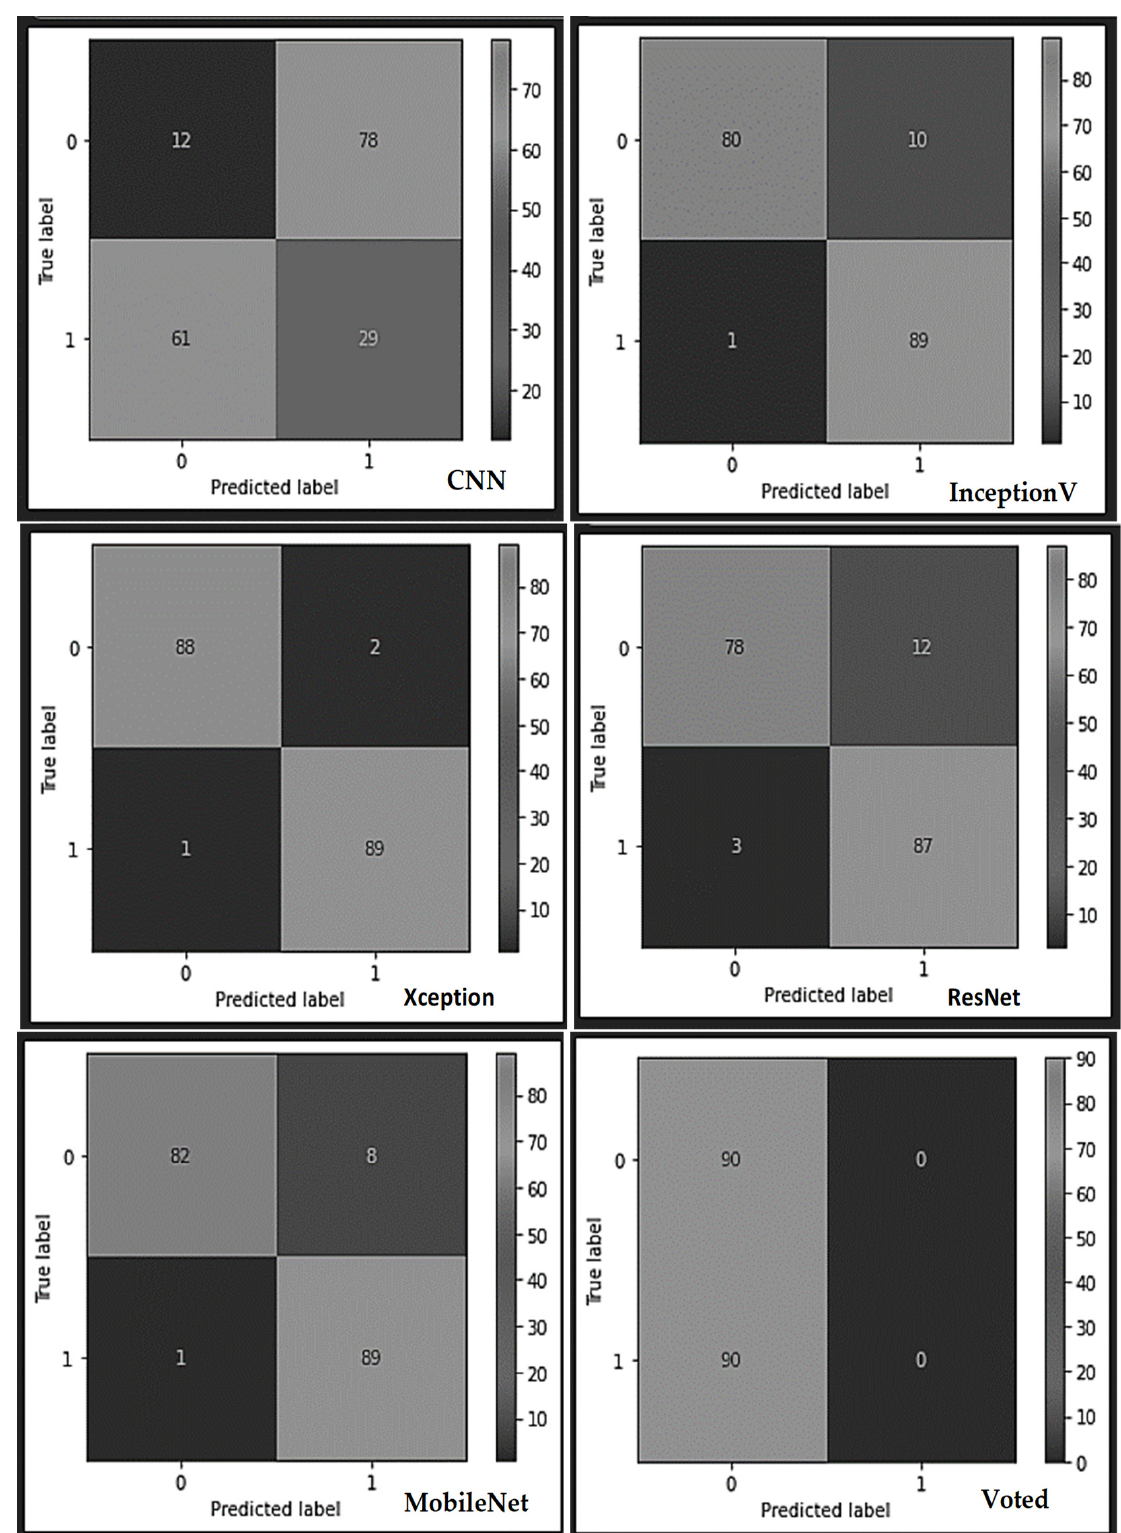
Figure 6. The various confusion matrices obtained from each learner using the industrial PCB da- taset.